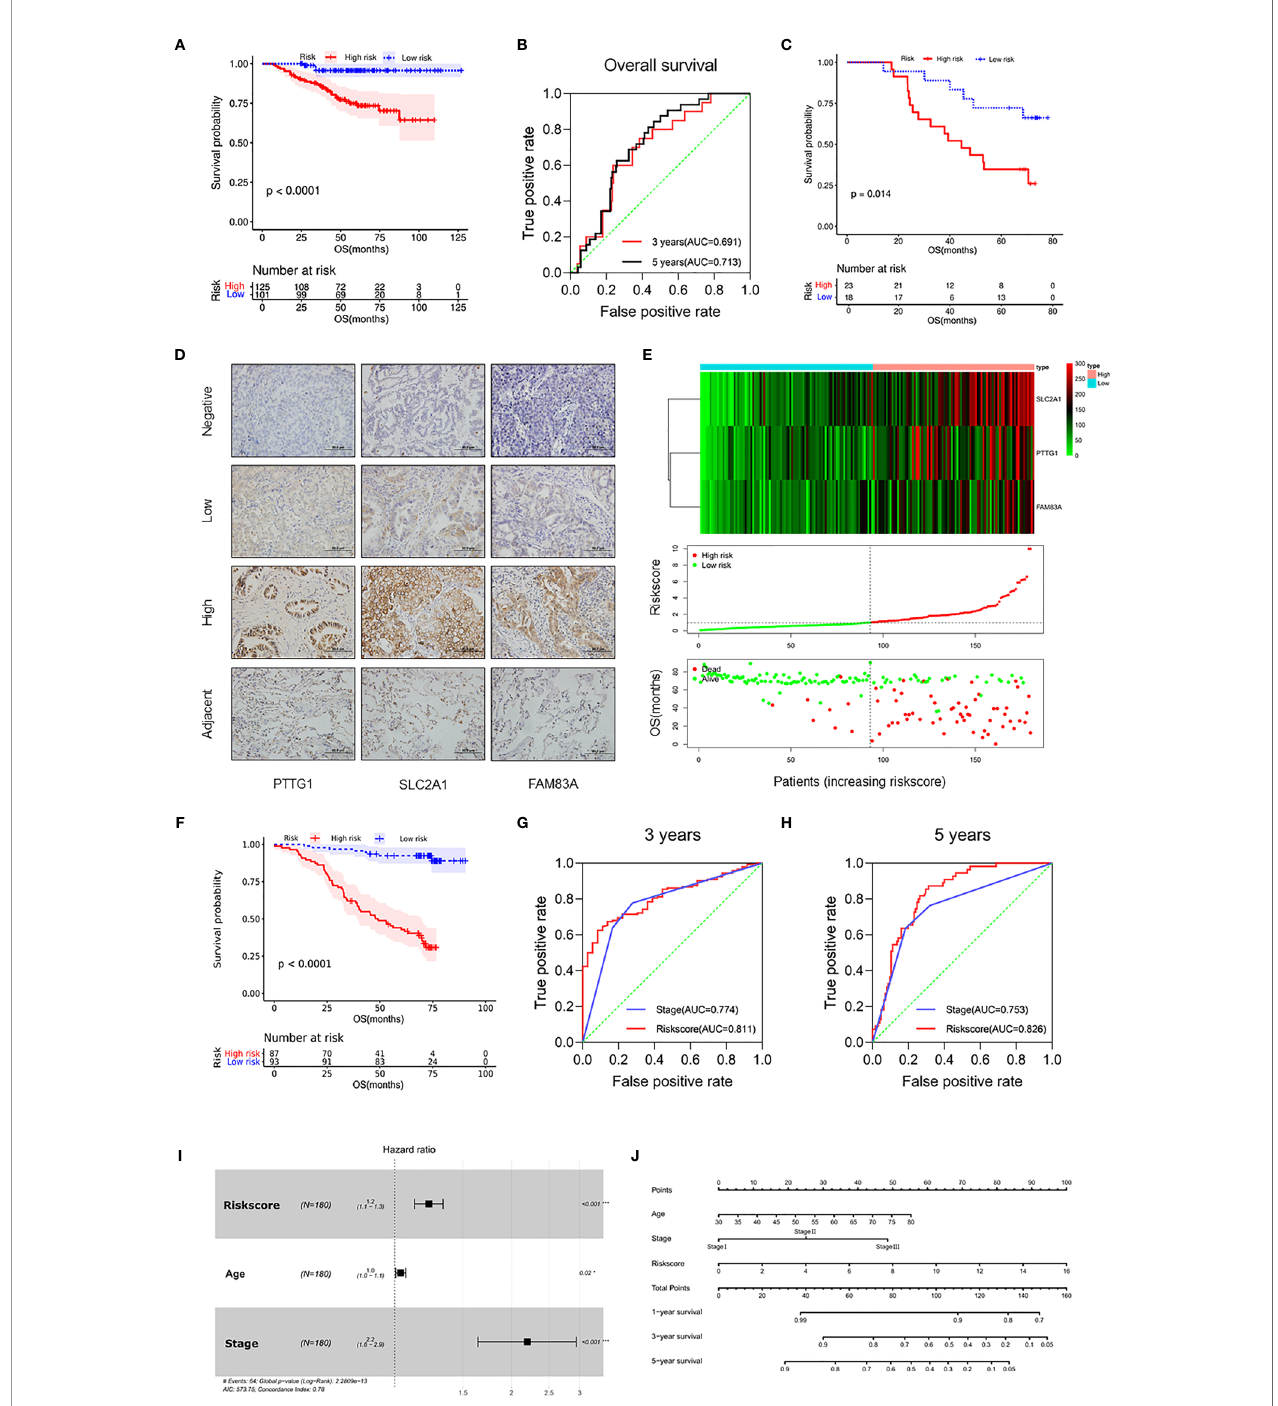
FIGURE 4 | Validation of the prognostic risk model in the LUAD cohort. (A) Kaplan – Meier curves for OS by risk subgroups in the GSE31210. (B) Time-dependent ROC curves measuring the prognostic value of the risk score at 3 and 5 years in the GSE31210. (C) Kaplan – Meier curves for OS by risk subgroups in the mRNA level from the Tianjin cohort. (D) Representative IHC images for staining of signatures in 180 samples of patients with LUAD (Olympus, ×400 magni fi cation, bar = 50 m m). (E) Heat map of PTTG1 , SLC2A1 , and FAM83A in the Tianjin cohort (upper fi gure). Distribution of risk score (middle fi gure), and OS (lower fi gure). (F) Kaplan – Meier curves for OS by risk subgroups in the Tianjin cohort. (G, H) Time-dependent ROC curves measuring the prognostic value of the risk score and stage at (G) 3 years and (H) 5 years in the Tianjin cohort. (I) Forest plot showing the independent prognostic factors for OS in the Tianjin cohort (multivariate Cox regression analysis). (J) Nomogram for predicting 1-, 3-, and 5-year overall survival in the Tianjin cohort. *p < 0.05 and ***p <